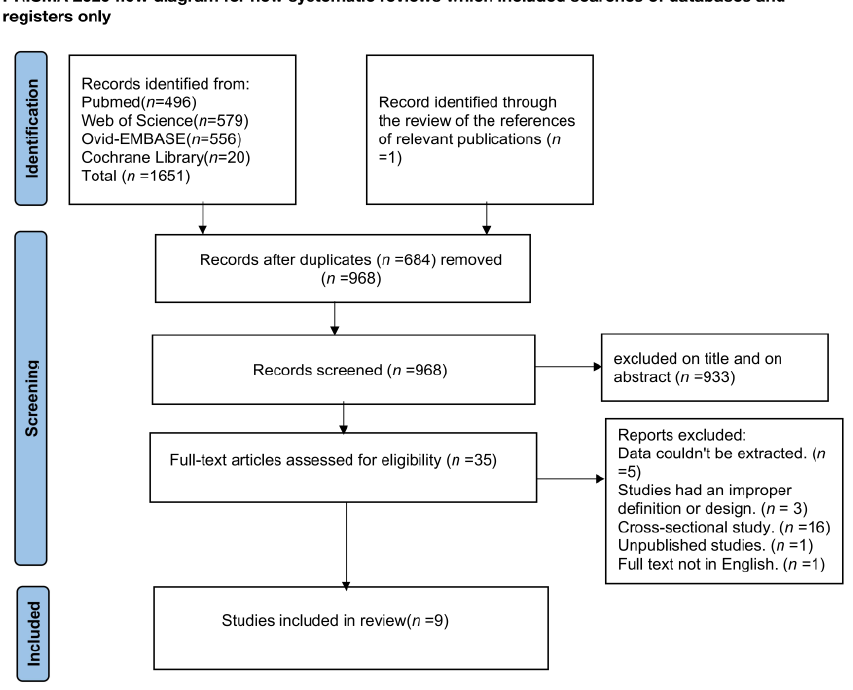
Figure 1. The detailed flow chart of the Literature